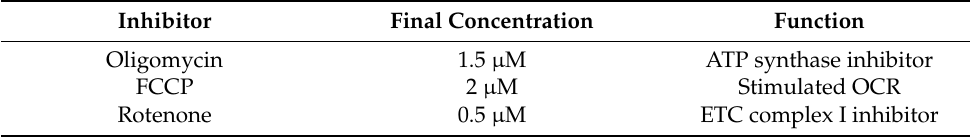
Table 2. Inhibitors of mitochondrial function for Mito Stress